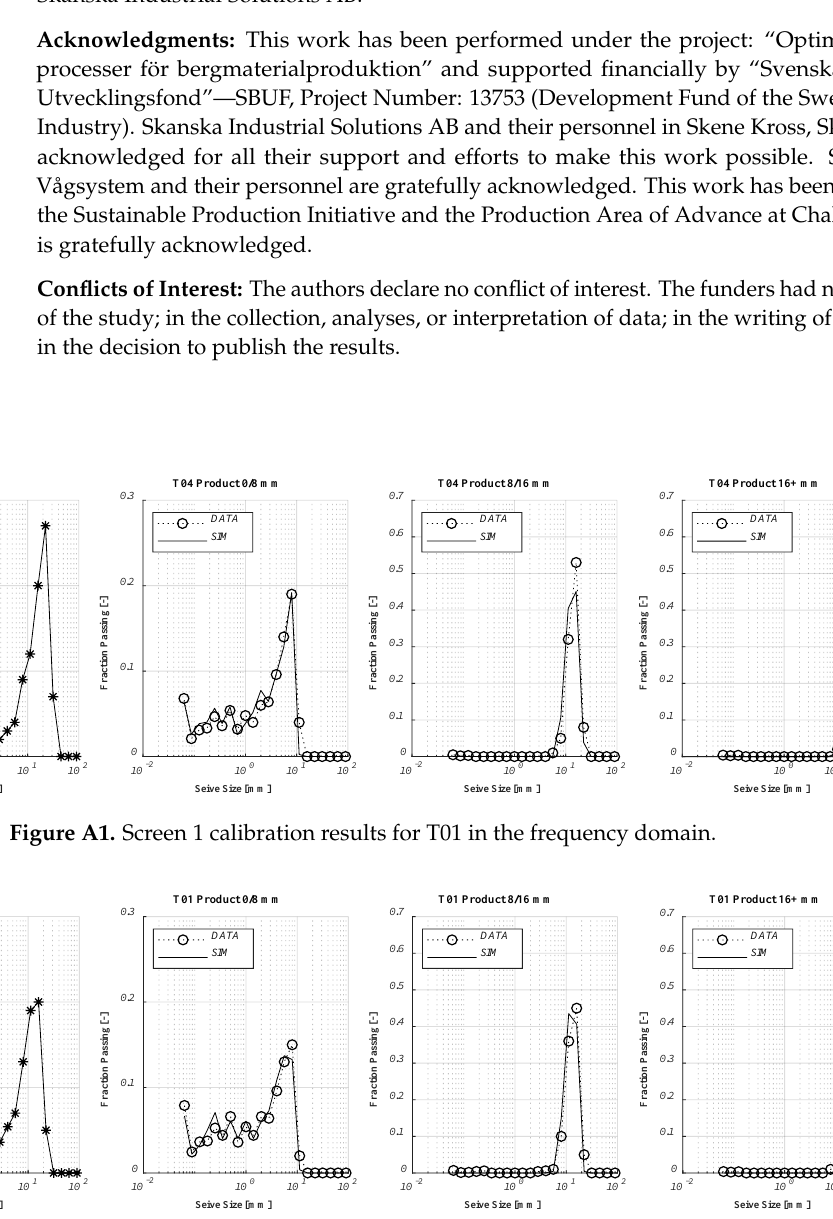
Figure A2. Screen 1 calibration results for T04 in the frequency domain.